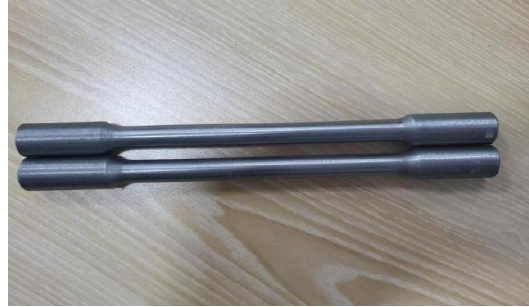
Figure 6. Finite element model of aluminum alloy specimen.